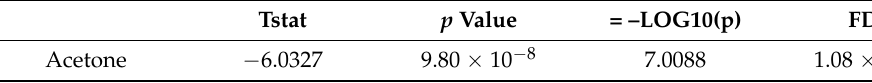
Table 4. VOC identified by SPME as significantly different in heart failure.